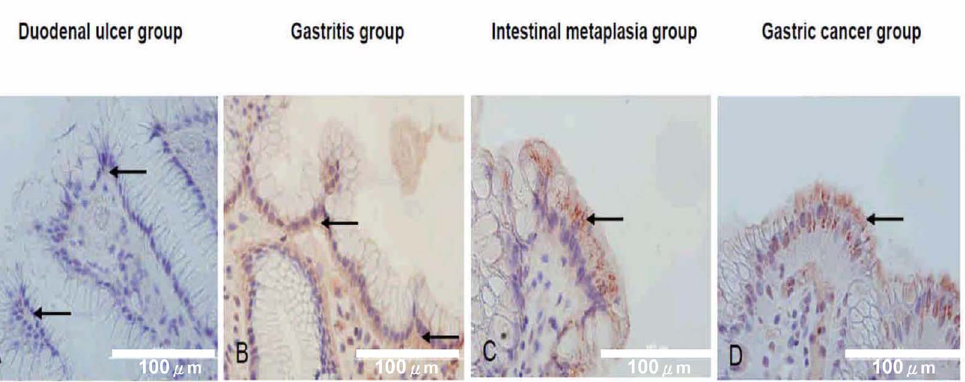
Figure 4. The immunohistochemical stains for integrin a 5 b 1 in the gastric superficial epithelial cells (40X) in the duodenal ulcer group, gastritis group, intestinal metaplasia group, and gastric cancer group, respectively. The integrin a 5 b 1 was stained on the basolateral membrane of the gastric superficial epithelial cells in the duodenal ulcer group (arrows in A ) and gastritis group (arrows in B ), but stained on supranuclear or apical surfaces in the intestinal metaplasia group (arrows in C ) and gastric cancer group (arrows in D ).